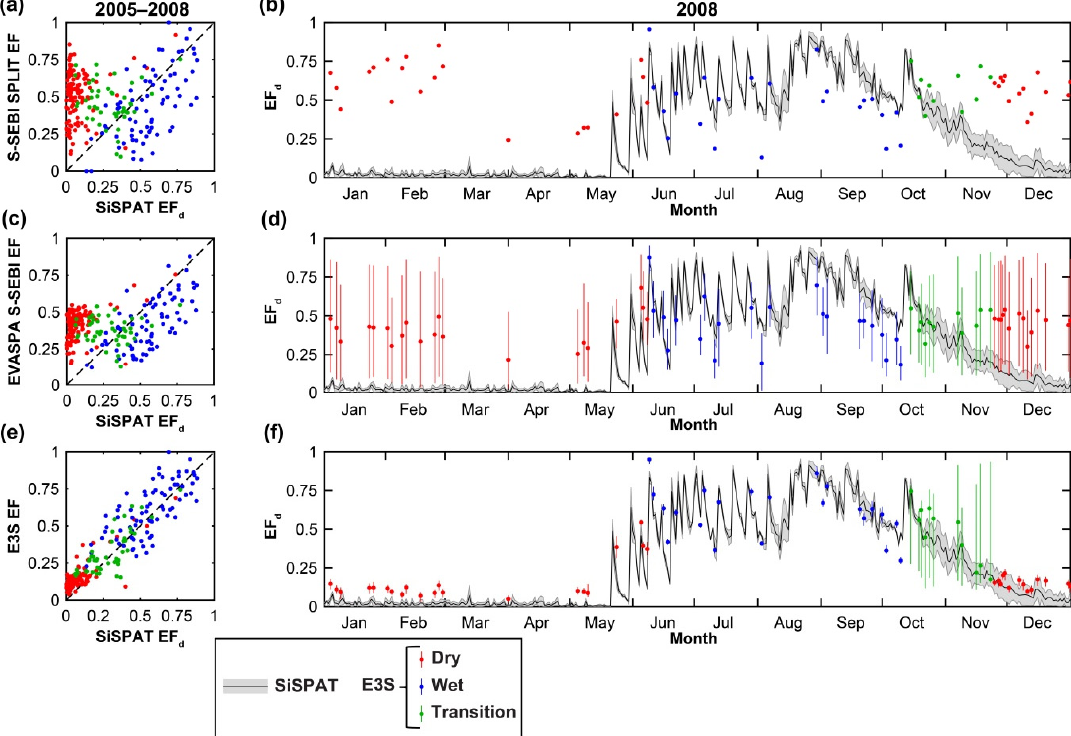
Figure 5. Evaporative fraction EF estimated with TERRA data by three different edge determination approaches (top to bottom) versus SiSPAT daily EF , for the whole study period (left) and for 2008 (right). ( a) and ( b ): non-ensemble SPLIT algorithm, Verstraeten et al., 2005; ( c ) and ( d ): original EVASPA S-SEBI unweighted ensemble method; ( e ) and ( f ): E3S weighted ensemble. Uncertainty bars ( d ) and ( f ) correspond to ensemble ranges, conditioned to weighting scheme for E3S ( f ).